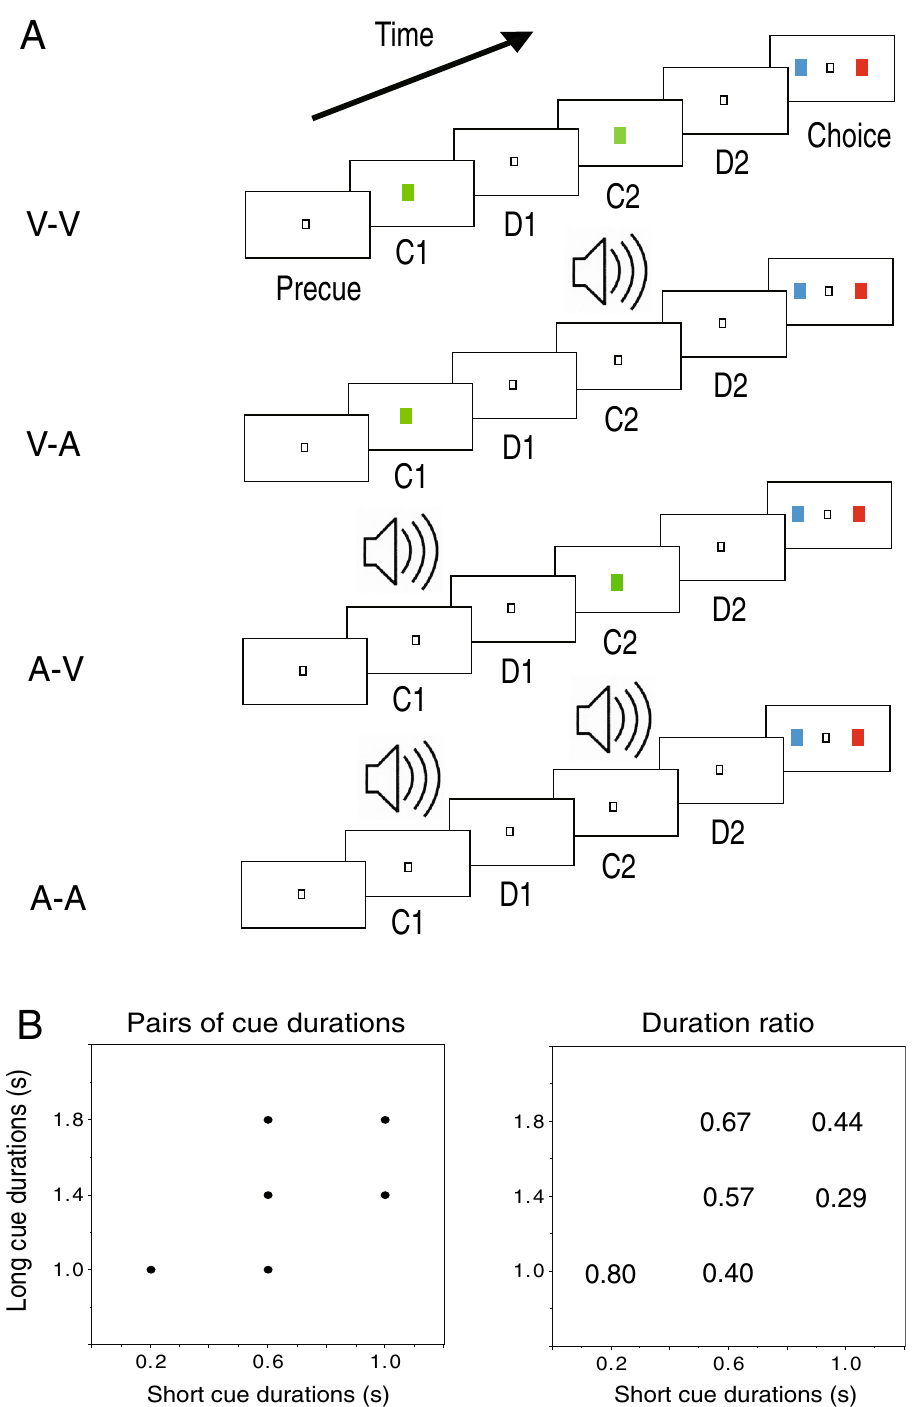
Figure 1. Behavioral task and pairs of cue durations. ( A ) Sequences of the duration discrimination task with auditory and visual cues. C1, first cue; D1, first delay; C2, second cue; D2, second delay. Four modality sequences of C1 and C2 were adopted: V-V, visual-visual; V-A, visual-auditory; A-V, auditory-visual; A-A, auditory-auditory. ( B ) Pairs of cue durations (left) and cue duration ratios (right) used in the task. Cue duration ratio = (long duration − short duration)/long